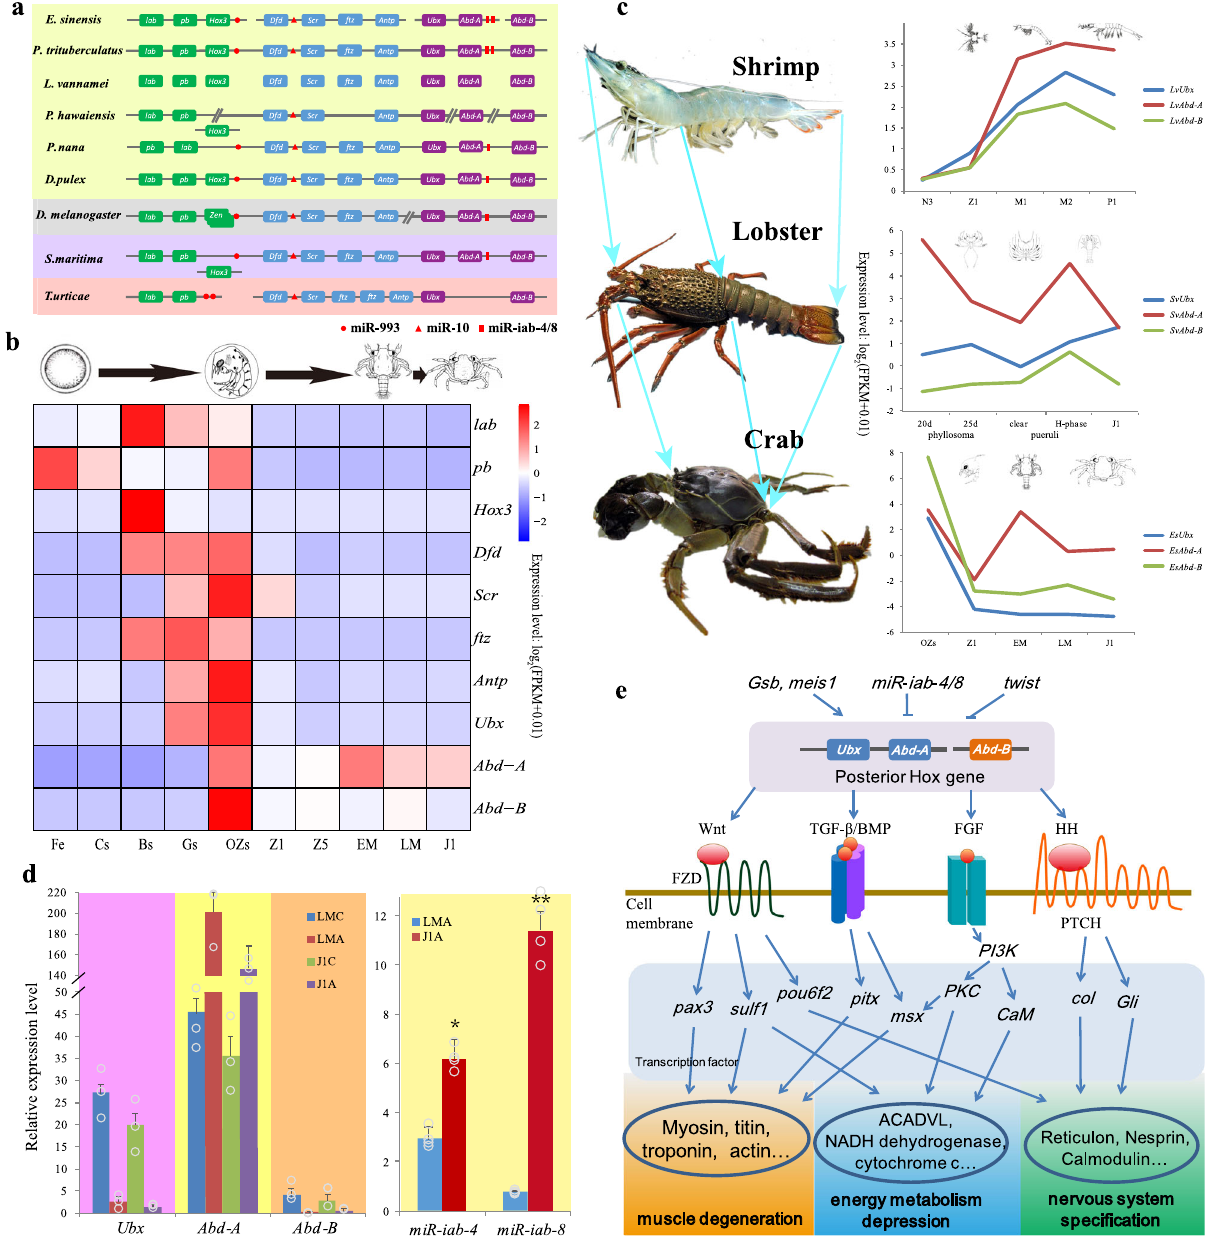
Fig. 4 The conserved homeobox gene clusters and their expression and regulation in E. sinensis . a Genomic organization of Hox genes in E. sinensis and selected arthropods. Different colored boxes indicate different Hox gene groups, including anterior (green), central (blue), and posterior (purple). Red shapes indicate the position of miR-993, miR-10 and miR-iab-4/8 genes. Split lines indicate that the cluster is located on different scaffolds. Oblique lines indicate the regions of the Hox cluster that are non-contiguous or interrupted on the same scaffold. b Temporal expression of E. sinensis Hox cluster genes. Fe fertilized egg, Cs 2 – 4 cell stage, Bs blastula stage, Gs gastrula stage, Ozs original zoea stage, Z1 zoea I, Z5 zoea V, EM early megalopa stage, LM late megalopa stage, J1 the fi rst juvenile instar. c The expression and comparison of Ubx , Abd-A , and Abd-B genes in shrimp L. vannamei , lobster S. verreauxi and crab E. sinensis . The photo of S. verreauxi was provided by John Booth, National Institute of Water and Atmospheric Research, New Zealand. d The expression of posterior Hox genes ( Ubx , Abd-A , and Abd-B ) and miRNAs ( miR - iab - 4 and miR - iab - 8 ) in the cephalothorax and abdomen of the late megalopa (LM) and juvenile instar (J1) stages. LMC represents the cephalothorax of LM, and LMA represents the abdomen of LM, J1C represents the cephalothorax of J1, J1A represents the abdomen of J1. Error bars represent the mean ± S.D. ( n = 3 in Hox expression and n = 4 in miRNA expression). Signi fi cant differences across LMA (two-tailed Student ’ s t -test) are indicated with an asterisk at P < 0.05, and two asterisks at P < 0.01. e The speculative regulation process of the posterior Hox gene during the brachyurization metamorphosis in E. sinensis .